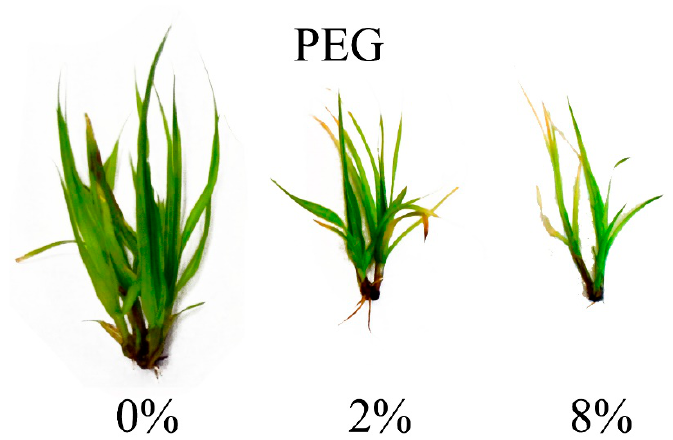
Figure 1. Growth of explants on the medium supplemented with PEG after 4 weeks of cultivation.